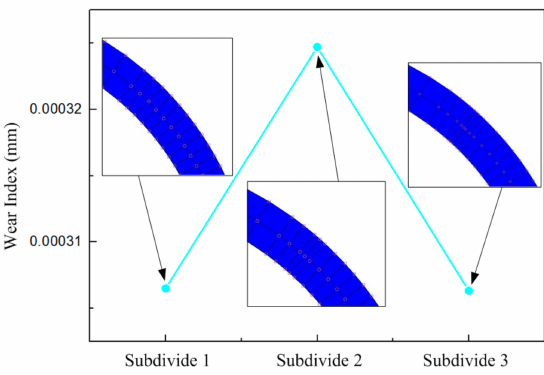
Figure 6. Grid independence verification.